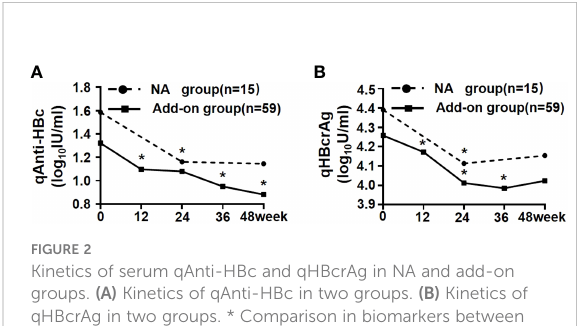
FIGURE 2 Kinetics of serum qAnti-HBc and qHBcrAg in NA and add-on groups. (A) Kinetics of qAnti-HBc in two groups. (B) Kinetics of qHBcrAg in two groups. * Comparison in biomarkers between this and last time points and p < 0.05. NA, Nucleos(t)ide analogs; qAnti-HBc, quantitative anti-hepatitis B core antibody; qHBcrAg, quantitative hepatitis B core-related antigen.